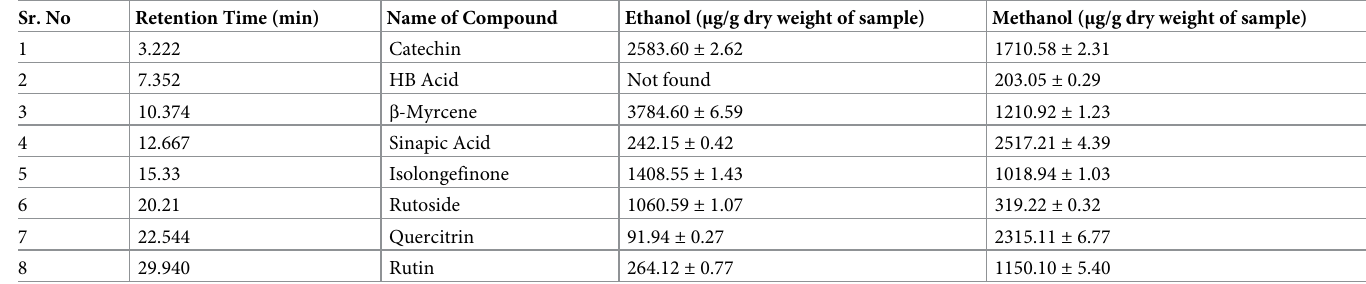
Table 4. Contents of major polyphenols ( μ g/g of dry weight) in two different extracts of Artemisia absinthium , based on ethanol and methanol as solvent. Sr.